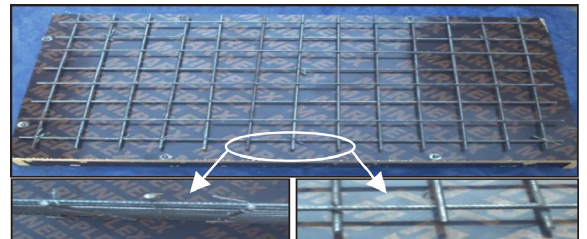
Figure 2: Details of the reinforcement mesh used for concrete